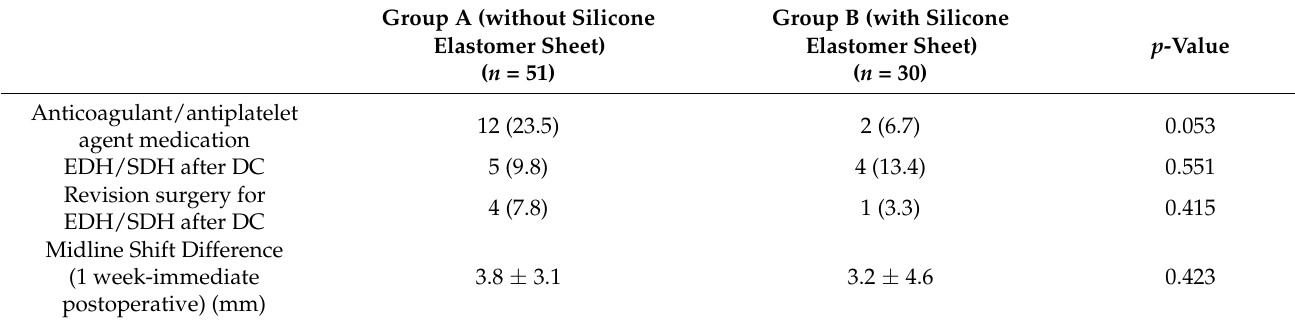
Table 2. Difference between complications and midline shift between the two groups after DC.